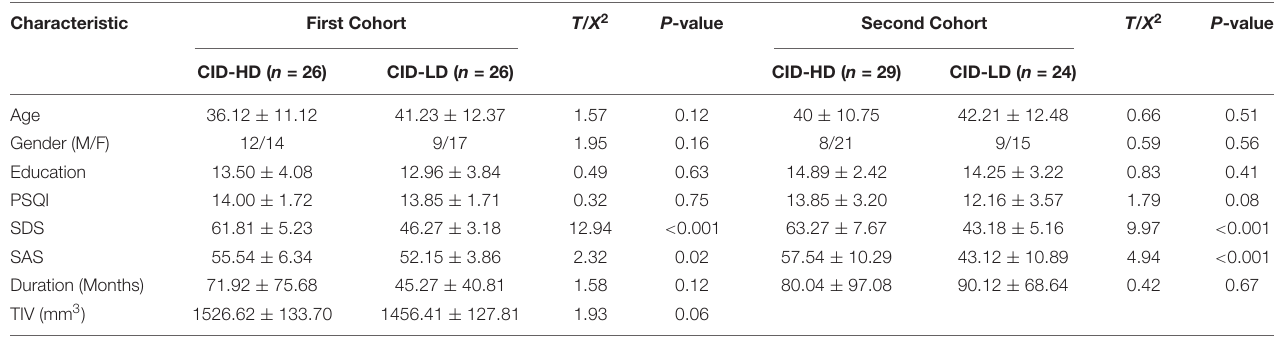
TABLE 1 | Demographic and clinical traits for two CID groups.